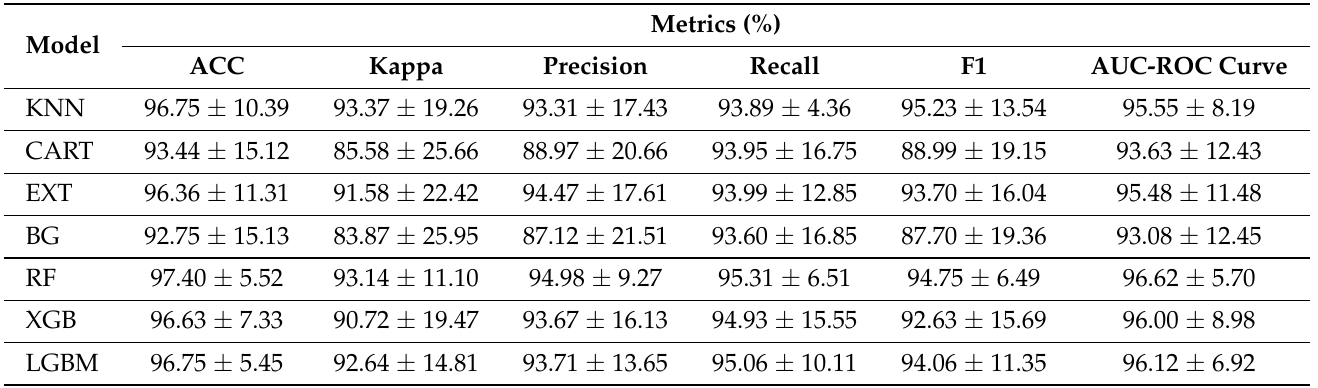
Table 4. Metrics obtained during the model selection phase.